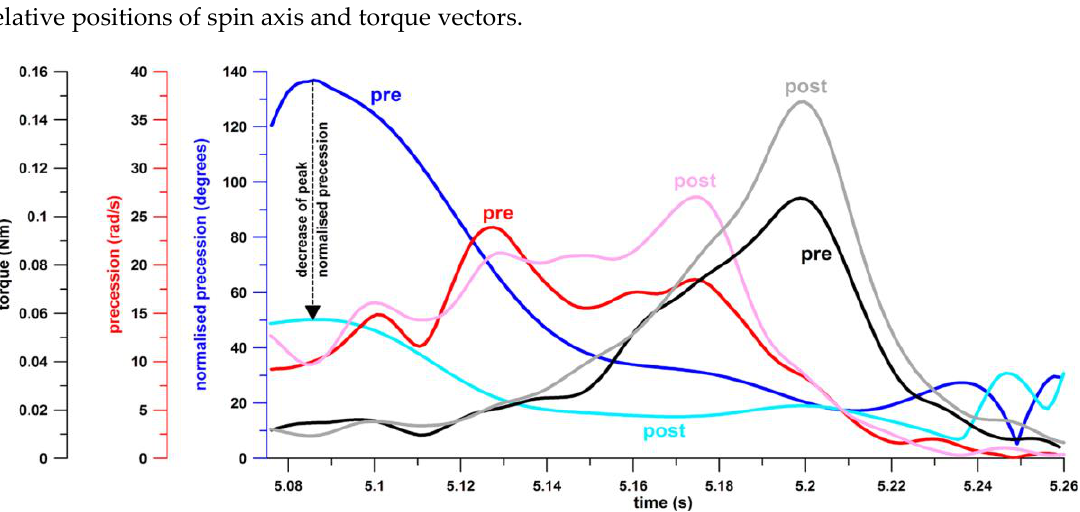
Figure 2. Torque, precession and normalized precession against time of 2 deliveries, one before (pre) and one after (post) intervention; the decrease of the normalized precession is indicated by an